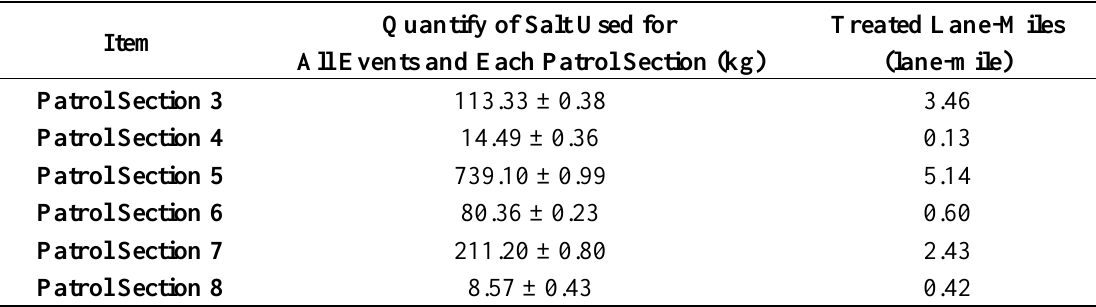
Table 7. “Uncertainty analysis: Quantify of